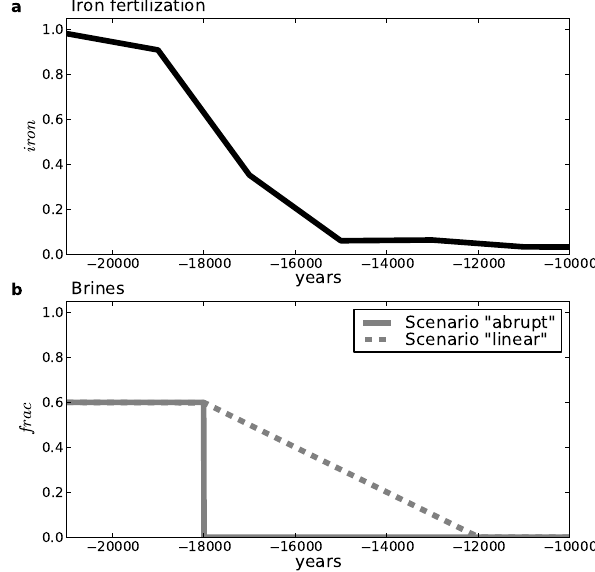
Fig. 6. Evolution scenarios for (a) iron fertilization and (b) the sink- ing of brines during the last deglaciation. The two processes are active at the beginning of the simulations then stop. The iron fer- tilization decline follows the dust transport as recorded in ice cores (Wolff et al., 2006) on the EDC3 age model (Parrenin et al., 2007). The halt of the sinking of brines follows two scenarios: a sudden halt (“abrupt”) or a linear decline